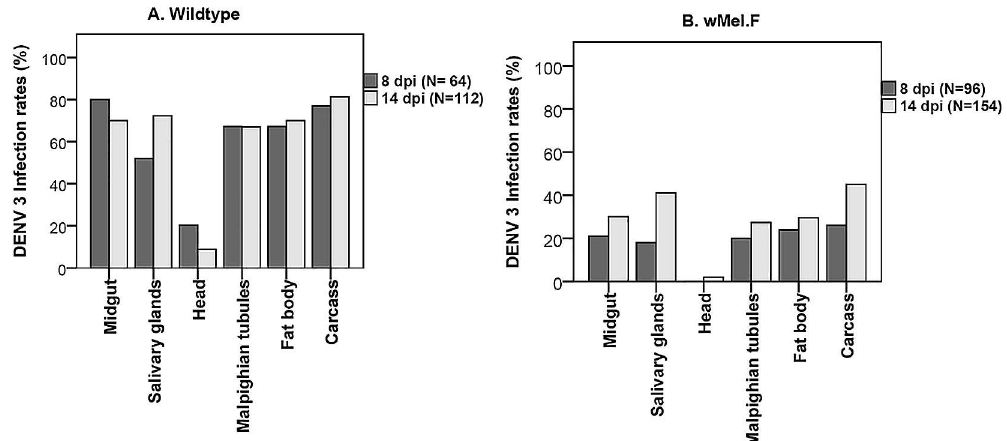
Fig 1. DENV infectionrates in Ae . aegypti tissues for Wildtype (A) and w Mel.F (B) at 8 and 14